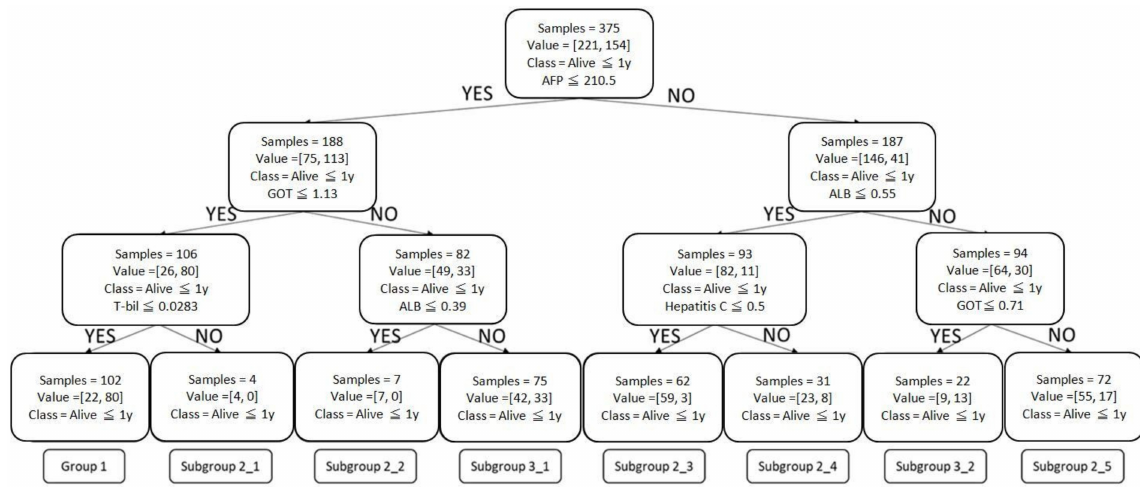
Figure 1. CART under Maximum 3 Layers. Table 3. The Classification of